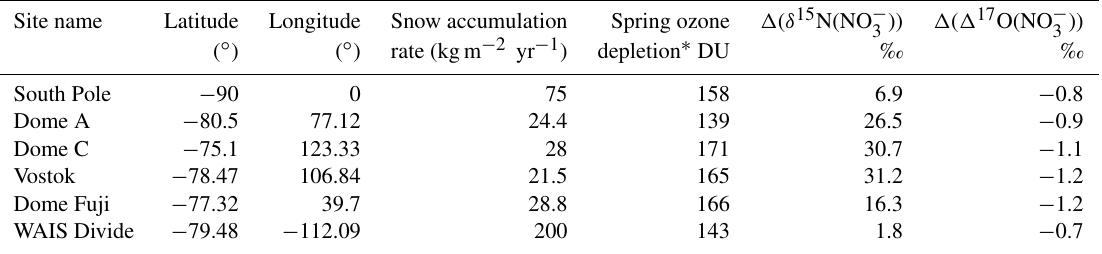
Table 1. Model-calculated maximum isotope changes resulting from the Antarctic ozone hole (i.e., the differences between isotopes in the pre-ozone hole period and those in year with the most depletion) at different Antarctic